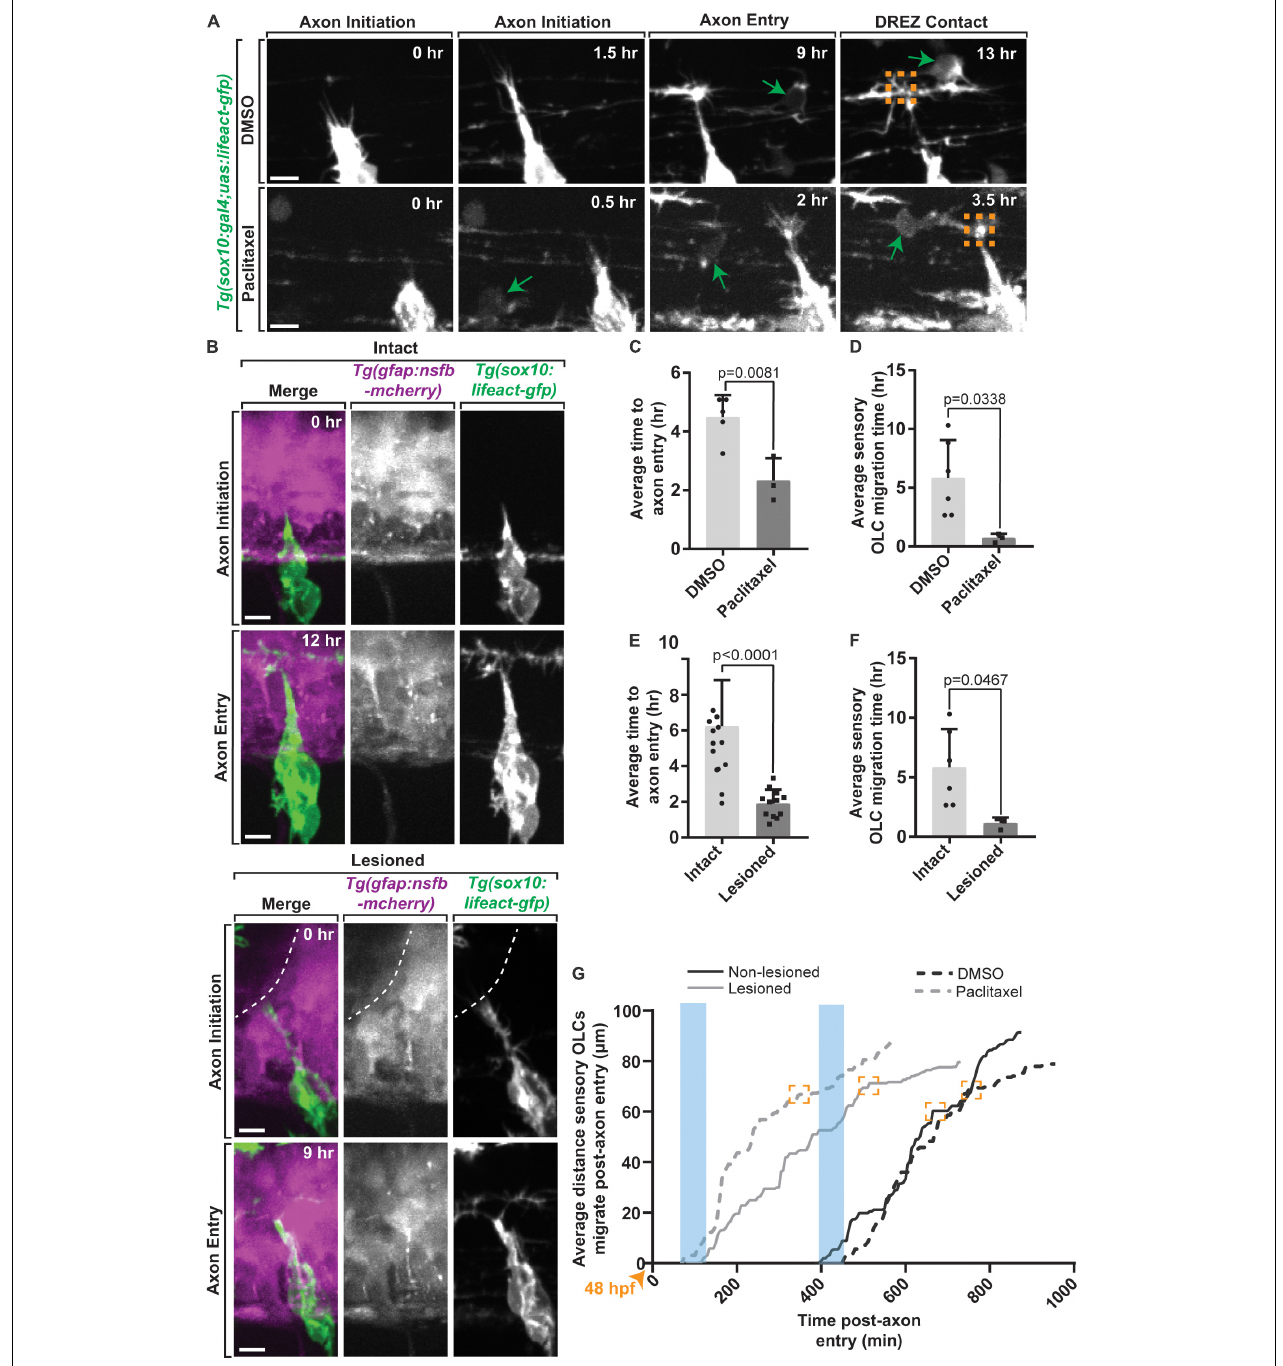
FIGURE 5 | Early axon entry promotes early OPC migration to sensory nerves. (A) Images from a 24 h time-lapse movie starting at 48 hpf in Tg(sox10:gal4; uas:lifeact-gfp) zebrafish treated with Paclitaxel showing axon initiation and sensory-related OLC and DREZ contact earlier than typical axon entry. Green arrows represent migrating sensory-related OLC. (B) Still Images from a 24 h time-lapse movie starting at 48 hpf in intact and lesioned Tg(sox10:gal4;uas:lifeact-gfp);Tg(gfap:nsfb-mcherry) zebrafish also showing axon initiation and successful axon entry earlier than typical axon entry. White dashed line indicates lesion site. (C) Quantification of average time to axon entry in DMSO and Paclitaxel treated animals ( p = 0.0081). (D) Quantification of the average time to sensory-related OLC migration post-axon entry in DMSO and Paclitaxel treated animals ( p = 0.0338). (E,F) Paralleled quantifications of C-D in Lesioned and Non-lesioned animals ( D = p < 0.0001, E = p = 0.0467). (G) Quantification of the average distance and time three OLCs migrated post-axon entry in DMSO and Paclitaxel treated animals and lesioned and non-lesioned animals. Orange arrowhead indicates start of timelapse at 48 hpf. Blue rectangles highlight the time of axon entry. Orange boxes indicate OLC-DREZ contact. Scale bar equals 10 µ m (A,B) . All images are orientated anterior to left, posterior to right, dorsal up and ventral down.